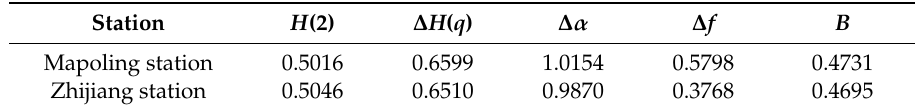
Table 2. Multifractal parameters of daily precipitation time series data at the Mapoling and Zhijiang